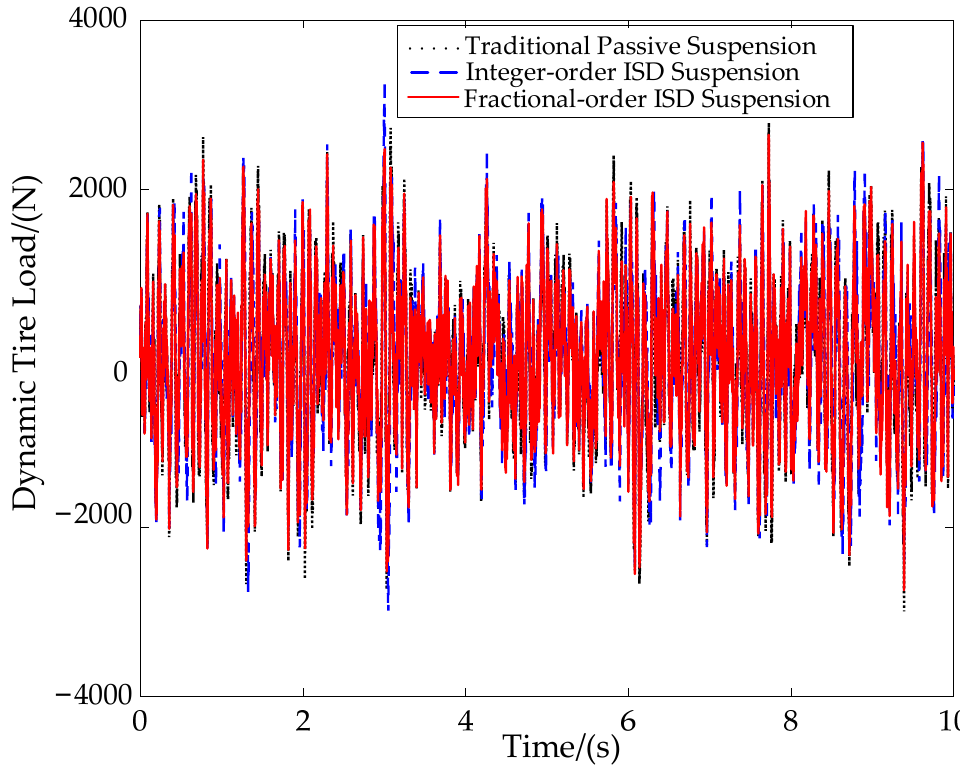
Figure 9. Comparison of the suspension working space.